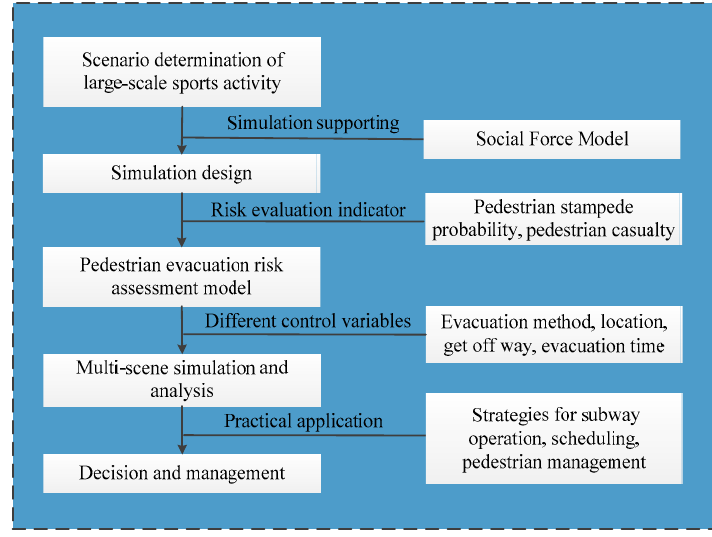
Figure 1. Pedestrian risk management flowchart.